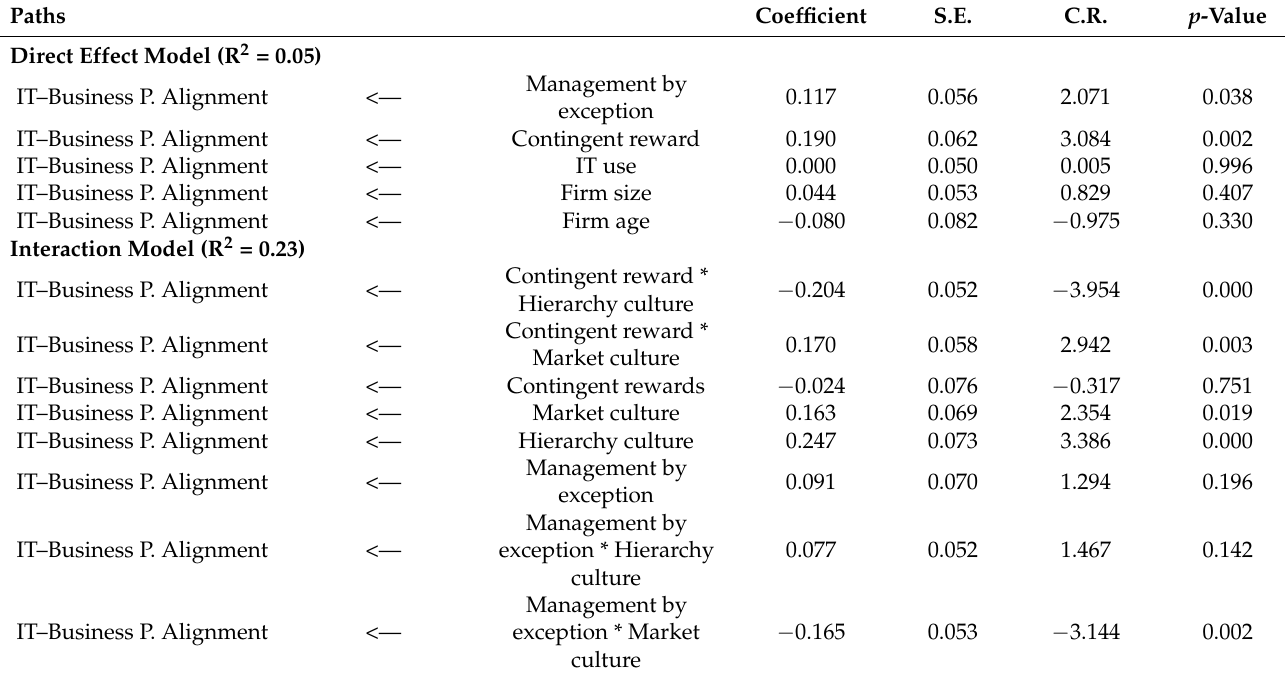
Table 3. Direct and moderating